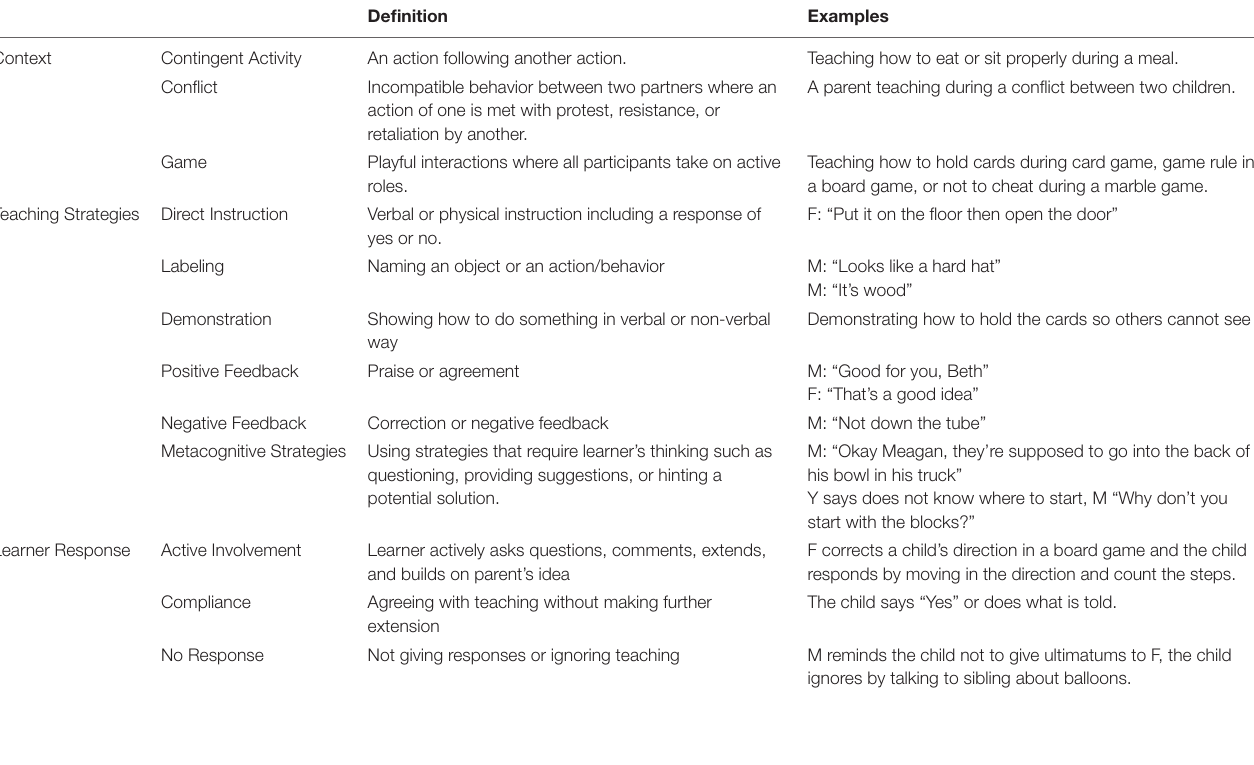
TABLE 2 | Definitions and examples of contexts, teaching strategies, and child’s